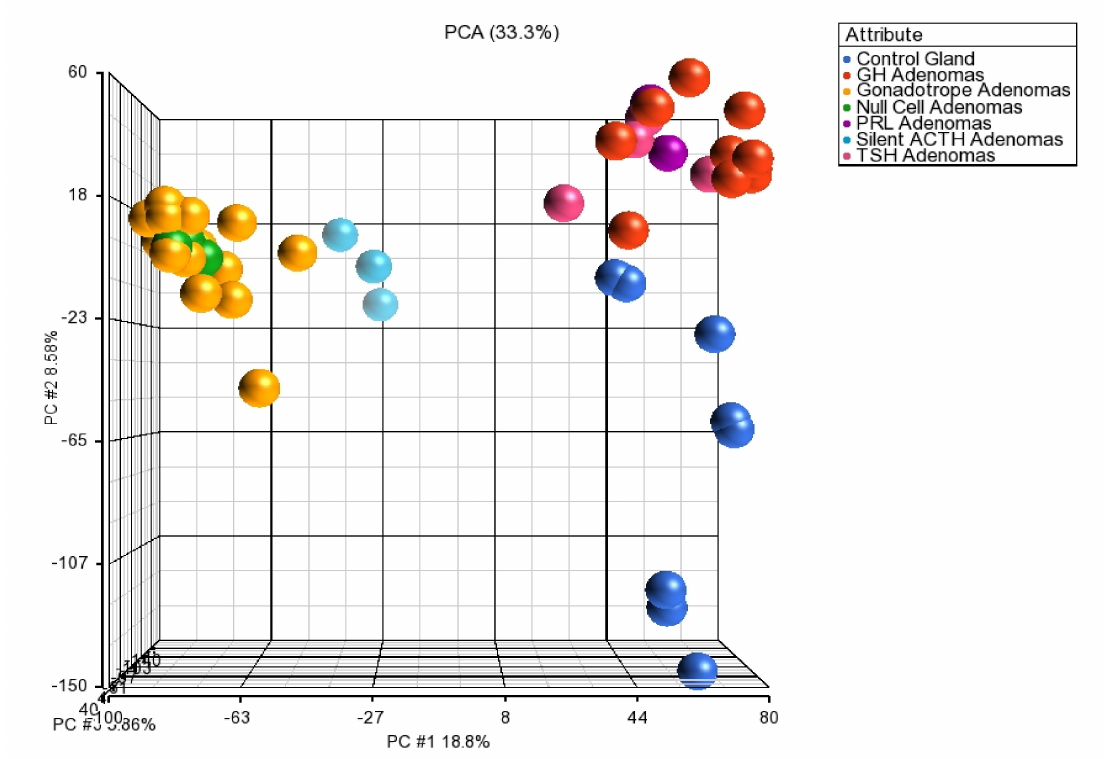
Figure 8. Principal component analysis of the pituitary tissue transcriptome. POU1F1-derived tumors GH-, TSH- and PRL-secreting adenomas clustering together as one group separated from the NR5A1-deived tumors gonadotropes, null cell and silent ACTH adenomas which comprised a separate cluster, both tumor lineages were isolated from control glands. Blue dots represent the control gland, red dots represent GH tumors, purple dots = PRL adenomas, pink dots = TSH adenomas, yellow dots = gonadotrope adenomas, green dots = null cell adenomas and cyan dots = silent ACTH